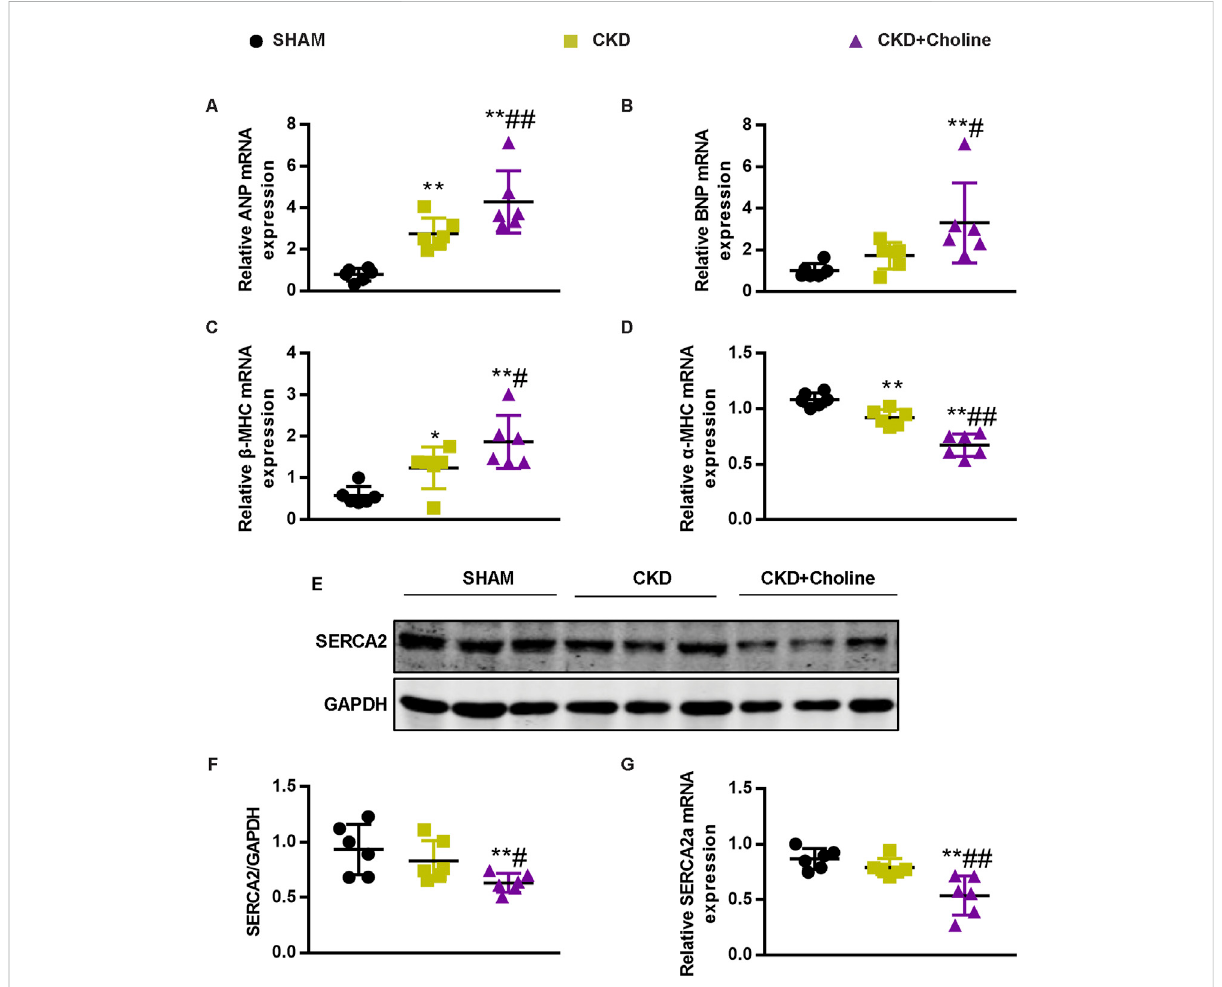
levels of SERCA2 were measured by western blotting. (F) Graphic representation of relative abundance of SERCA2 normalized to GAPDH. (G) The mRNA levels of SERCA2 were measured by real-time PCR. The data are presented as the mean ± SD. * p < 0.05 and ** p < 0.01 vs. SHAM